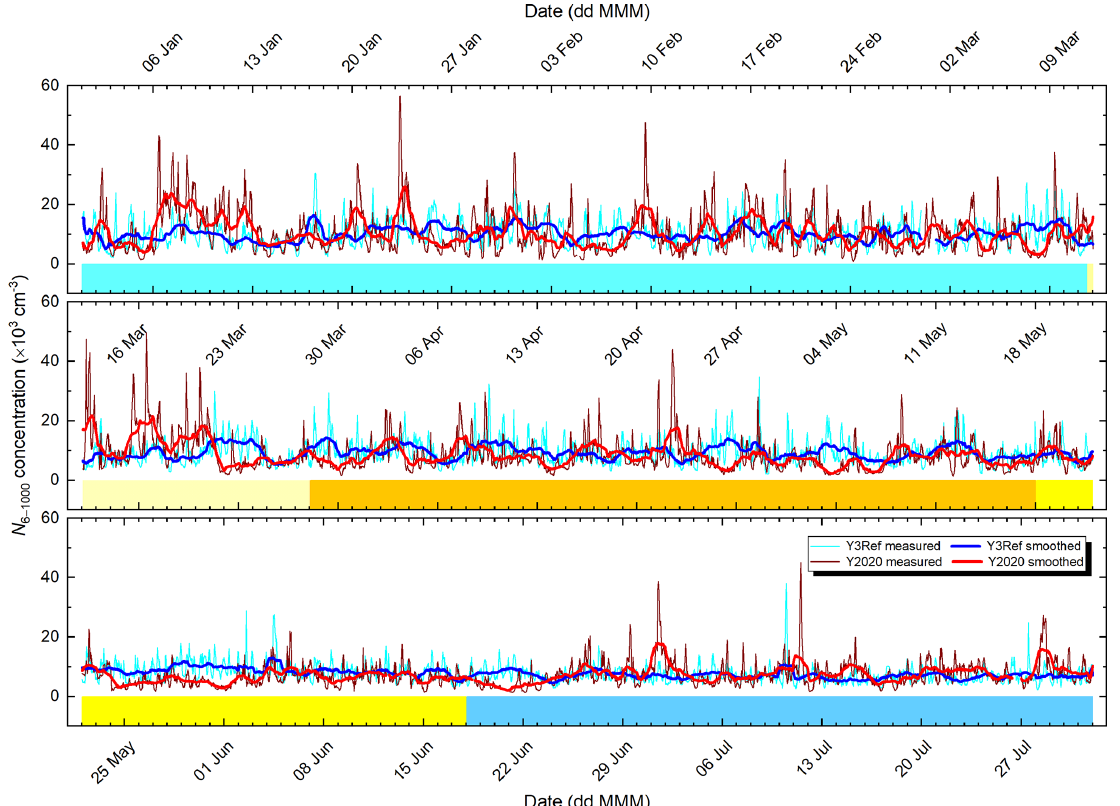
Figure 6. Time series of N 6–1000 concentration in the average reference year comprising 2017–2019 (Y3Ref) and year 2020 together with their 24h smoothed curves over the five consecutive phases of the first COVID-19 outbreak. The phases are marked by the following colour codes: Pre-emergency phase lighter blue, Pre-restriction phase lighter yellow, Restriction phase orange, Post-restriction phase darker yellow and Post-emergency phase darker blue. The tick labels of the abscissa indicate the Mondays in